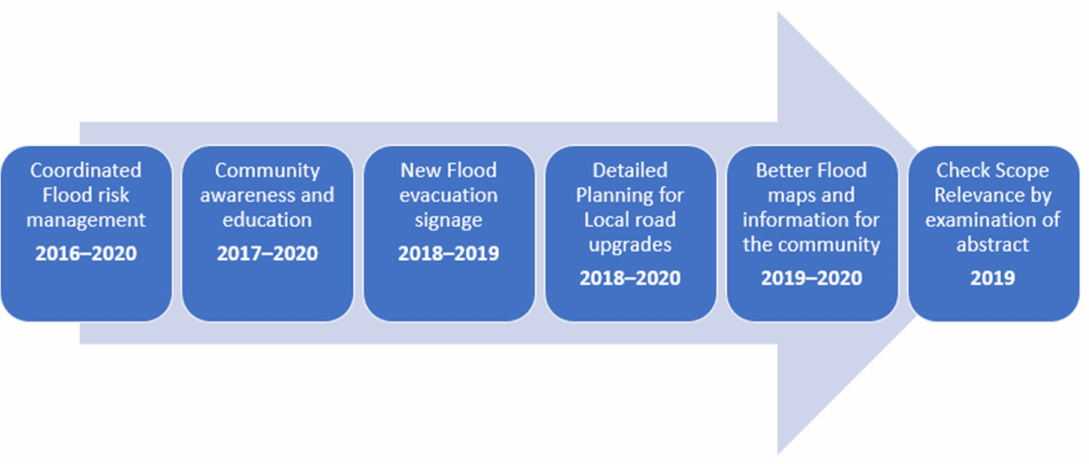
Figure 7. The timeline and milestones for the implementation of the flood management strategy for the Hawkesbury-Nepean